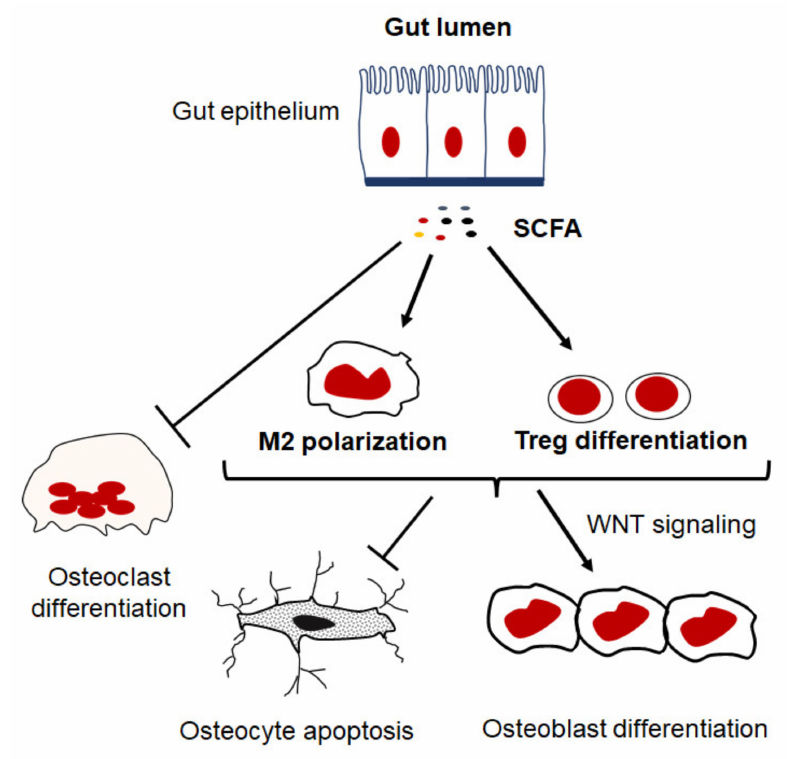
Figure 4. Potential regulatory role of SCFAs in inflammation and bone remodeling. SCFA, such as butyrate and propionate, inhibit osteoclastogenesis and promote differentiation of CD4 T cell into regulatory T cells (Tregs) and macrophages into an anti-inflammatory phenotype that facilitate an anabolic state in the bone